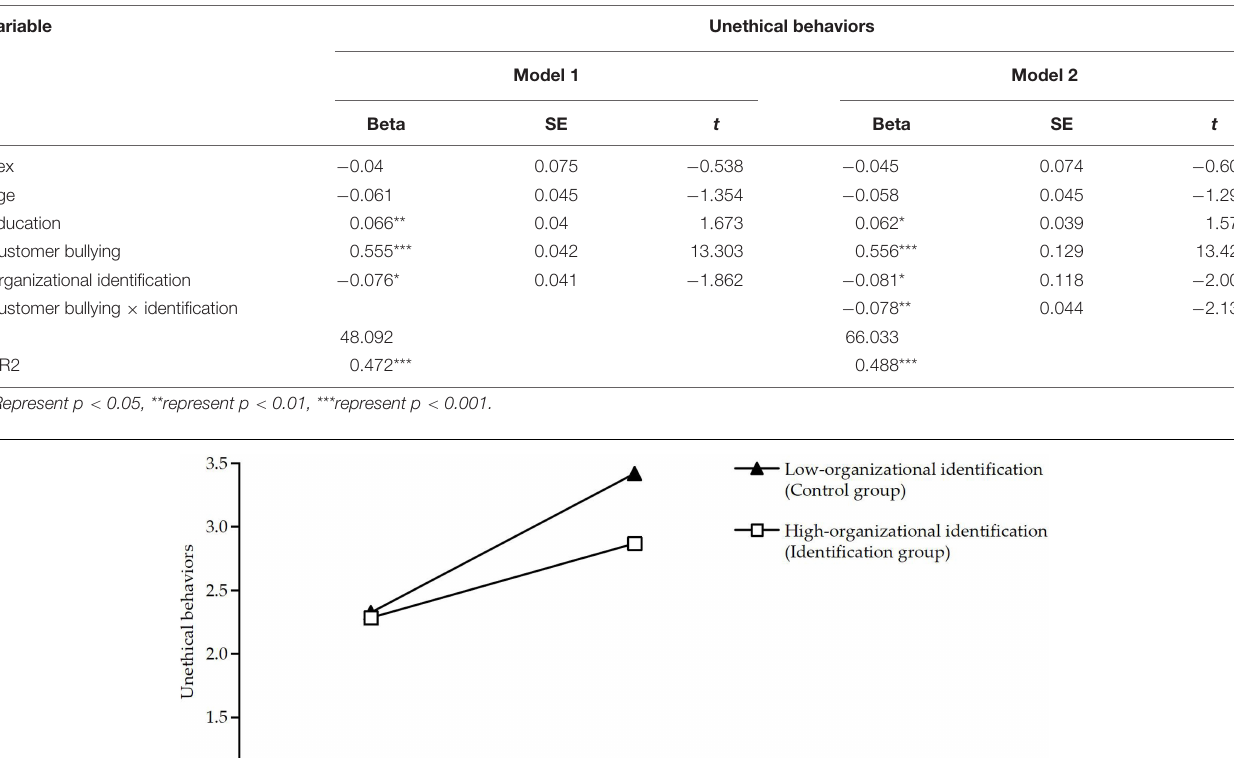
TABLE 6 | Regression results for direct and moderating effects.